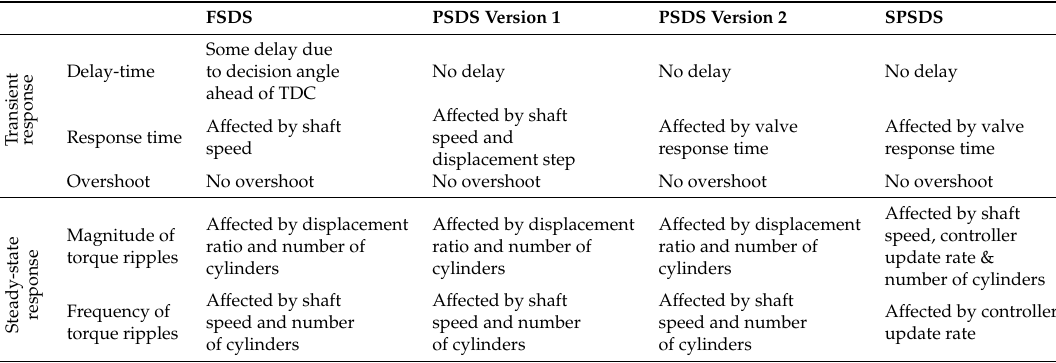
Table 5. Summary of transient and steady-state